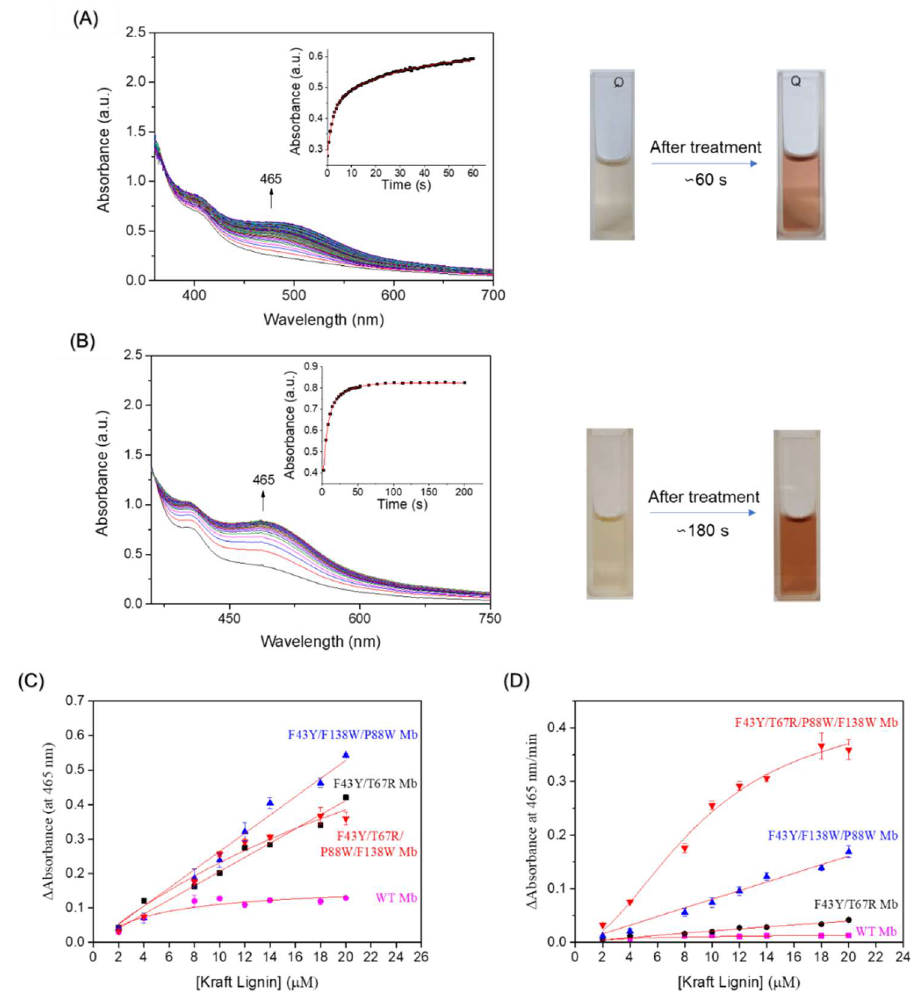
Figure 4. Kinetic studies of Kraft lignin (14 μM) oxidation in the presence of H 2 O 2 (2.0 mM) catalyzed by ( A ) F43Y/T67R/P88W/F138W Mb (2 μM) and ( B ) F43Y/F138W/P88W Mb (2 μM), respectively. Time-dependent changes of the absorbance at 465 nm were shown as insets and were fitted to the double-exponential decay function. The color changes upon reaction were shown in the right column. ( C ) The changes of absorbance at 465 nm after reacting for 1–10 min. ( D ) steady-state rates of oxidation with different concentrations of Kraft lignin, as catalyzed by F43Y/T67R/P88W/F138W Mb, F43Y/F138W/P88W Mb, F43Y/T67R Mb, and WT Mb, respectively. The plots were fitted to the Hill and Michaelis-Menten equations, respectively. The error bars in C and D were generated from triplicate experiments.